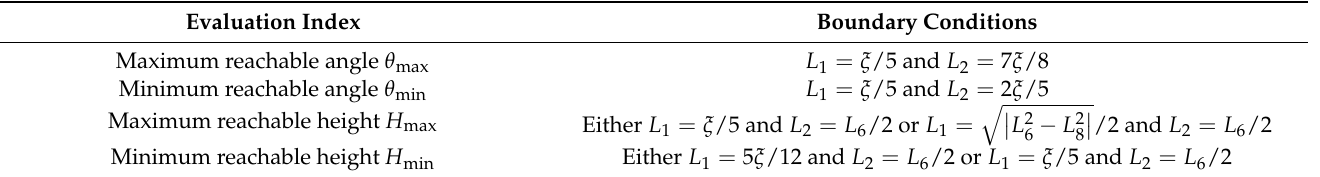
Table 3. Boundary conditions of evaluation indexes.